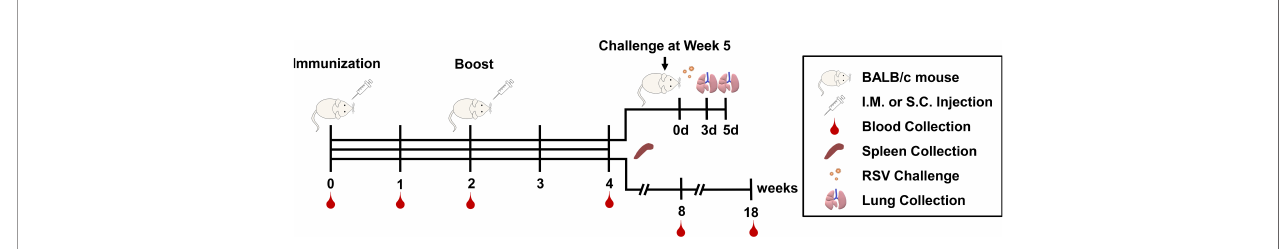
FIGURE 1 | Timeline for immunization, challenge, blood, and tissue sampling